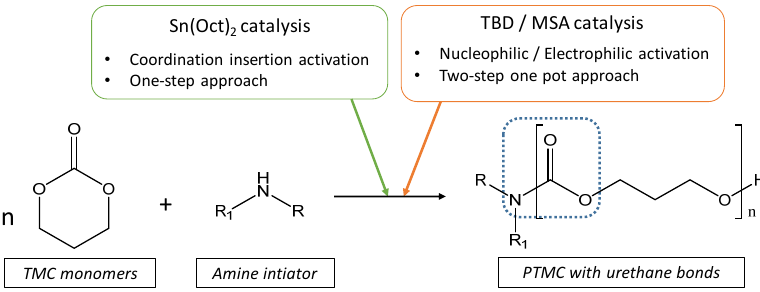
Figure 2. Overview on the catalysis pathways for the ROP-amine to synthesize the PTMC. Finally, ROP-amine of TMC has been tested using stannous octanoate catalyst. The 1 H NMR spectrum from Figure 3a shows the success of the ROP-amine with a conversion close to 100% after 24 h. The conversion rate is calculated by comparing the integrated areas of characteristic peaks of the protons from the monomers at 4.4 ppm with those from the growing polymer chains at 4.2 ppm ( H a ). Nevertheless, it is crucial to prove that the generated polymer has been well initiated by 1,6-hexanediamine. For that, 2D COSY NMR (Figure 3b) spectroscopy allowed to correlate a new peak at 3.1 ppm ( H c ) to the characteristic peak of the amino group at 4.7 ppm ( H f ), and also correlated to the characteristic peak of the protons from the aliphatic 1,6-hexanediamine at 1.5 ppm ( H d ) which can be assigned to the protons in alpha position of the resulting urethane. This peak has been used to calculate the average degree of polymerization in number of the PTMC which was close to the expected one (DP 100 ) (Table 1).